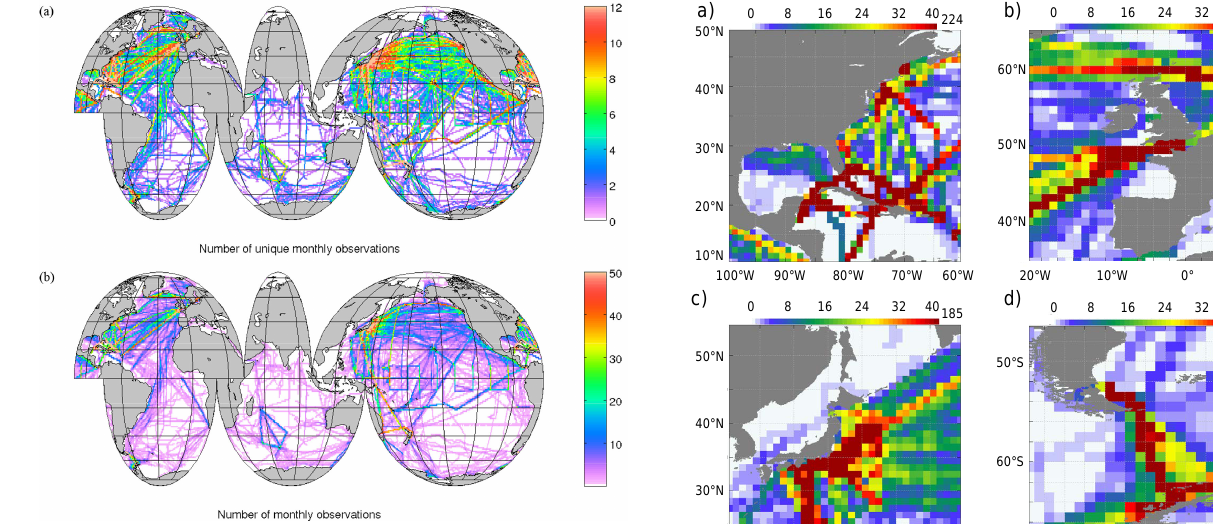
Figure 8. The number of (a) months of the year and (b) total months with surface water f CO 2 values in each 1 ◦ latitude by 1 ◦ longitude grid cell from 1970 to 2011 in SOCAT version 2. Fig- ure 8a updates a similar figure for version 1 in Sabine et al. (2013, Fig. 5).